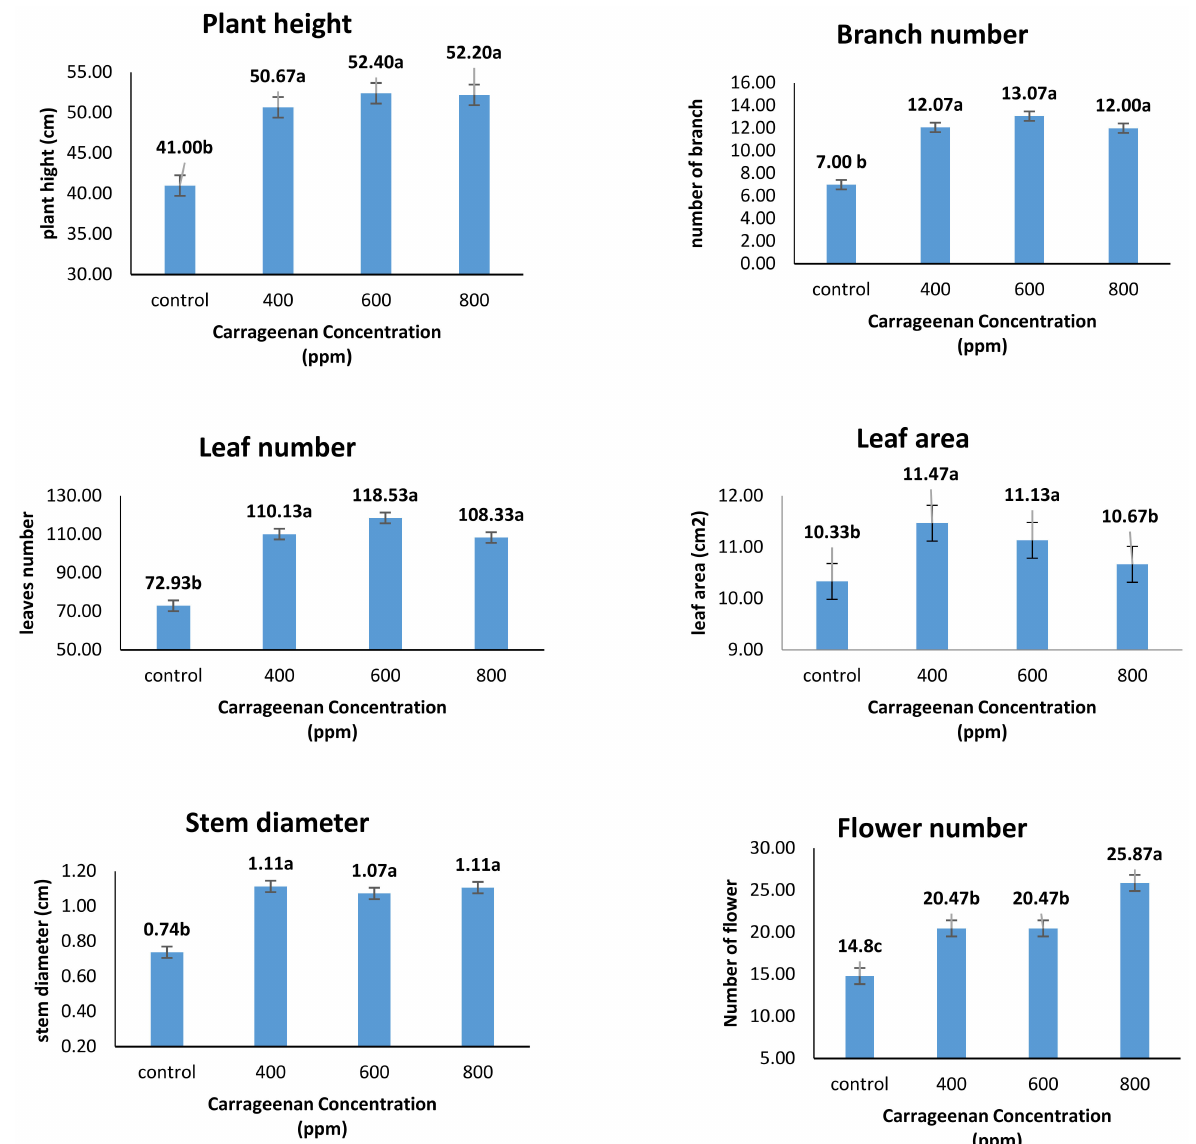
Figure 1. Effect of Carrageenan spraying on vegetative growth of Catharanthus roseus . Plant height (cm), lateral branches number, leaves number, leaf area (cm 2 ), stem diameter (cm) and number of flowers. Different letters indicate significant differences according to Duncan’s multiple range tests ( p <